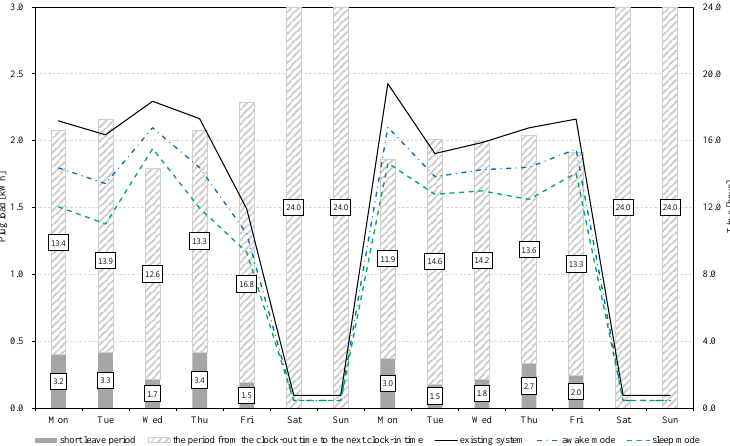
Figure 17. Occupant A, daily unoccupied time and plug load.